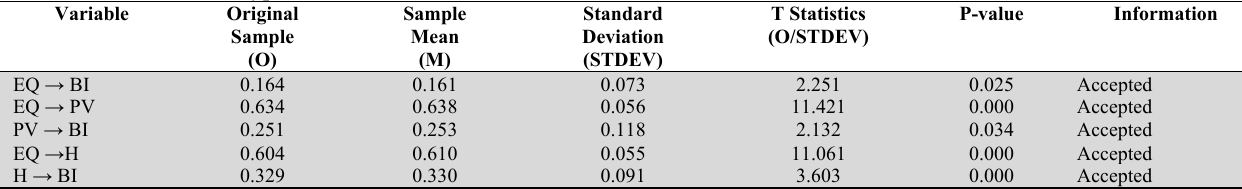
Result of Direct Effect Hypothesis Test